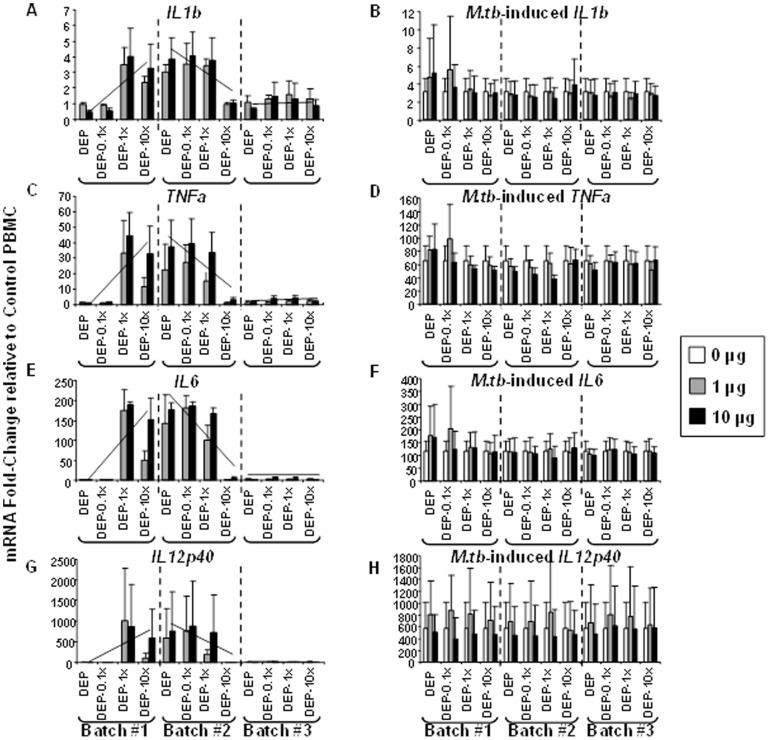
Effects of DEP and DEP-Env Exposure on Cytokine mRNA Expression in Human PBMC.PBMC from healthy donors (n = 3) were exposed to indicated concentrations of DEP, DEP-0.1x, DEP-1.0x, and DEP-10x from three independent batches (#1-3) in absence (A, C, E, and G) or presence (B, D, F, and H) of M.tb H37Ra at a multiplicity of infection (ratio of M.tb bacteria to blood monocytes within the PBMC) of 10 for 4 hours. The abundance of mRNAs encoding IL1b, TNFa, IL6 and IL12p40 was examined by real-time PCR assays as described before. Alterations of mRNA levels in PBMC exposed to DEP and DEP-0.1x, DEP-1.0x, DEP-10x samples are shown as mean fold-changes ± SD (y-axes) relative to unexposed (control) PBMC cultured in complete media. To demonstrate the change in the expression profile of mRNAs encoding IL1b, TNFa, IL6 and IL12p40 in cells exposed to DEP, DEP-0.1x, DEP-1.0x, and DEP-10x from batch #1-3, straight lines indicating the trends are inserted in the left panel.